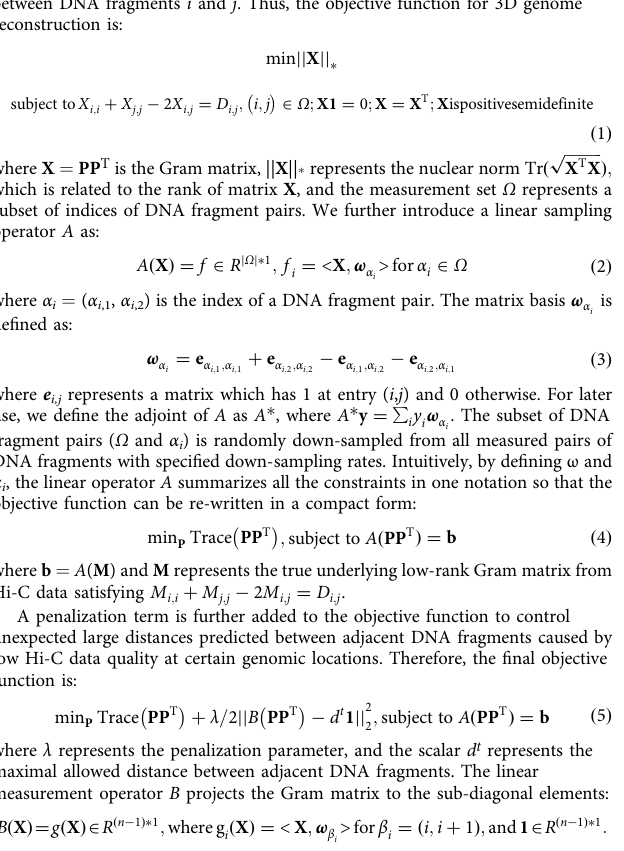
between predicted and benchmark structures were also calculated to quantify the